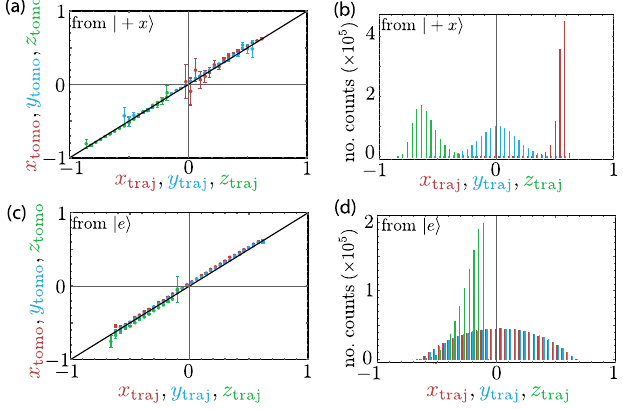
FIG. 3. Tomography versus quantum trajectories. (a) For each value of x a red dot indicates the average value x of the final traj tomo measurement of σ on the subset of experiments starting from x j þ x i and for which the quantum trajectory ends up at time 0 . 02 . Error bars T ¼ 4 μ s in a state such that h σ x x i ρ T ¼ traj (cid:2) represent the statistical uncertainty and the solid line has a slope 1. Subsets with less than 40 experiments are not shown. The final projective measurementinfidelity is corrected for[28]. Similar dots represent the case of y (blue) and z (green). (b) Distribution of the final Bloch coordinate i of the 10 6 quantum trajectories starting traj in j þ x i for T ¼ 4 μ s, and followed by a σ projective measure- i ment. The color code and the bin width match those in (a). (c),(d) Same as (a) and (b) for experiments starting in j e i